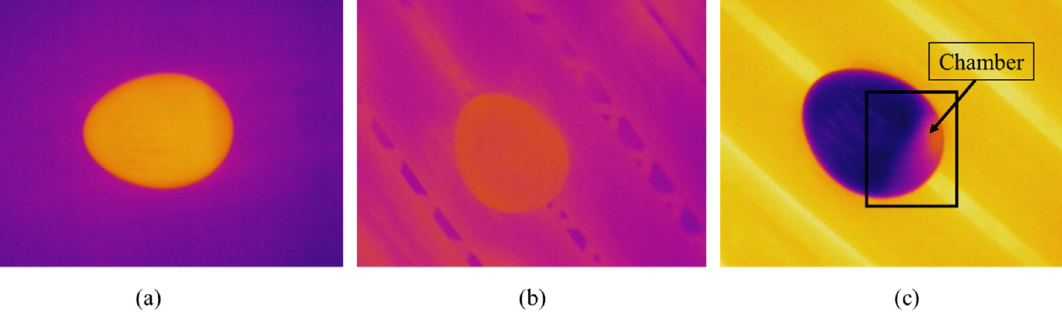
Figure 1. ( a ) Thermal image of an egg at room temperature. ( b ) Warmed egg at 37 °C. ( c ) Thermal picture from a cold egg at 17 °C while room temperature was 28 °C.